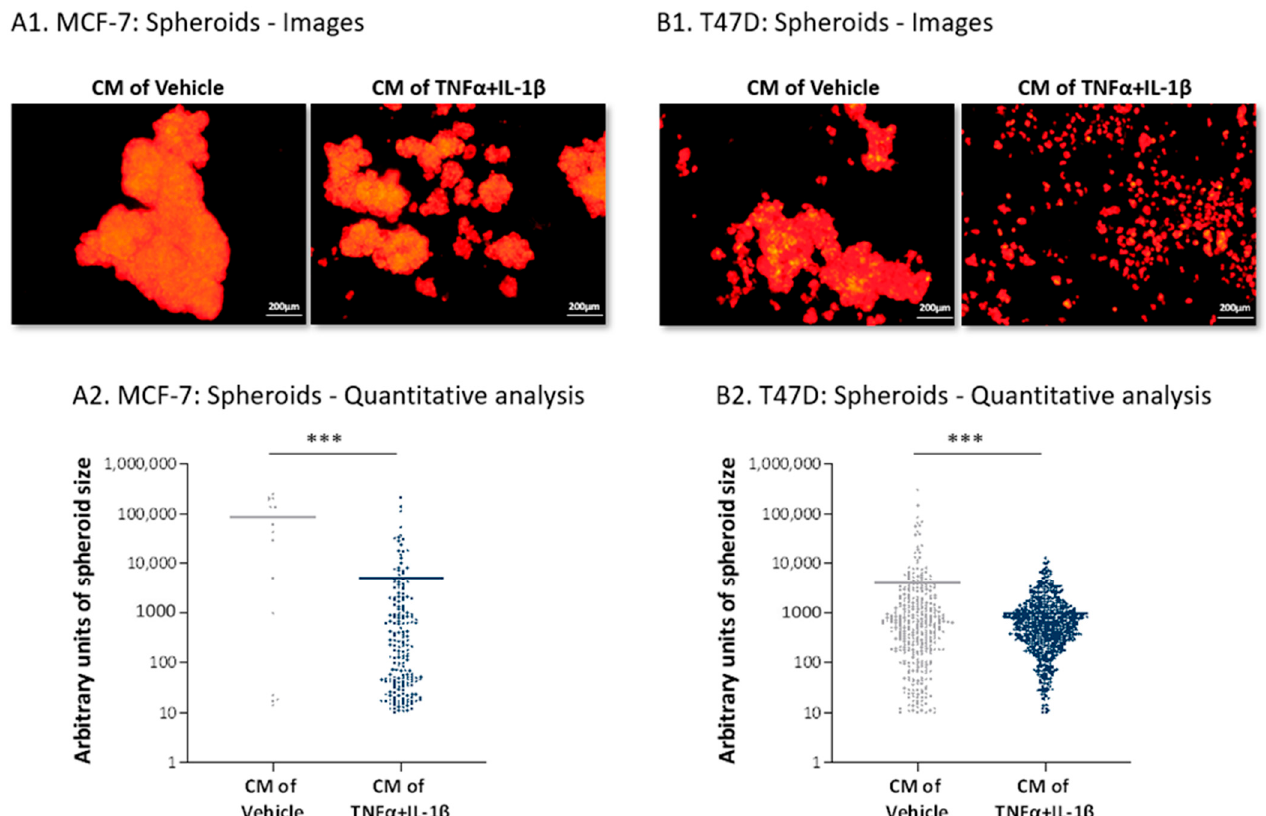
Figure 8. Following persistent stimulation of MSCs with TNF α + IL-1 β , the resulting inflammatory CAFs release factors that promote scattering of luminal-A BC cells. Human MSCs were exposed to persistent TNF α + IL-1 β stimulation (concentrations as in Figure 1) or to vehicles, generally for 14–18 days. Cytokine-devoid CM were collected as described in Figure 7 and were administered to mCherry-expressing MCF-7 ( A ) and T47D ( B ) human luminal-A BC cells, followed by determination of tumor cell scattering out of spheroids (MCF-7 cells) or the ability to form spheroids (T47D cells). ( A1 , B1 ) Representative images of spheroid formation at days 8 or 4 for MCF-7 cells and T47D cells are demonstrated, respectively. Bar, 200 μ m. The results of a representative experiment out of n = 3 are presented. ( A2 , B2 ) Quantitative analyses of spheroid sizes performed by the ImageJ program on images of the representative experiment ( n ≥ 7 images for each treatment). *** p < 0.001.